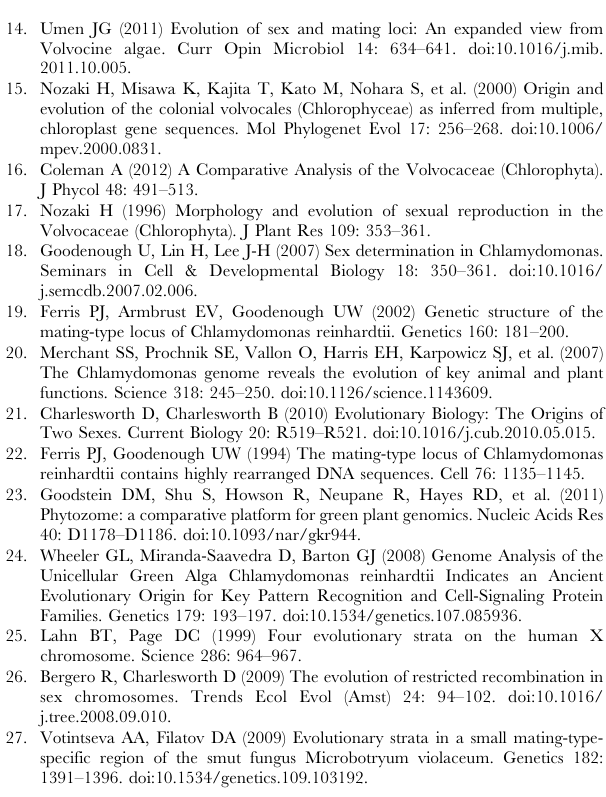
Table S6 Chlamydomonas reinhardtii strains and DNA sequences used for population genetic studies. Chlamydomonas Resource Center (http://chlamycollection.org/) strain numbers are listed along with common laboratory names for selected strains. Geographic origins are abbreviated as follows: FL, Florida; MA, Massachusetts; MN, Minnesota; NC, North Carolina; PA, Pennsylvania; QC, Quebec, Canada. Genbank accession numbers are listed for genes from each isolate. a Data from [37]. Table S7 Population data and haplotype differentiation for mating locus and autosomal genes. na not applicable. 1. Number of MT + and MT 2 strains analyzed for each gene. 2. Total number of silent sites (non-coding and synonymous) 3. Number of segregating silent sites. 4. Polymorphism rate for silent sites. Standard deviation in parentheses. 5. Tajima’s D statistic calculated for silent substitutions. Significant value (p , .05) is in bold. nd indicates not done for groups with less than 4 sequences. 6. d xy Average pairwise substitution rate between MT + and MT 2 isolates with Jukes-Cantor correction. 7. d A residual difference between MT + and MT 2 isolates when corrected for within- population divergence. Standard deviation in parentheses. Bold values are samples with dA scores outside of one standard deviation from the null value of zero. 8. Population differentiation between MT + and MT 2 isolates. Table S8 Recombination data for MT + homozygous cross. Parental strains K33 and CC-2344 (both MT + ), were crossed and progeny that showed recombination between NIC7 and THI10